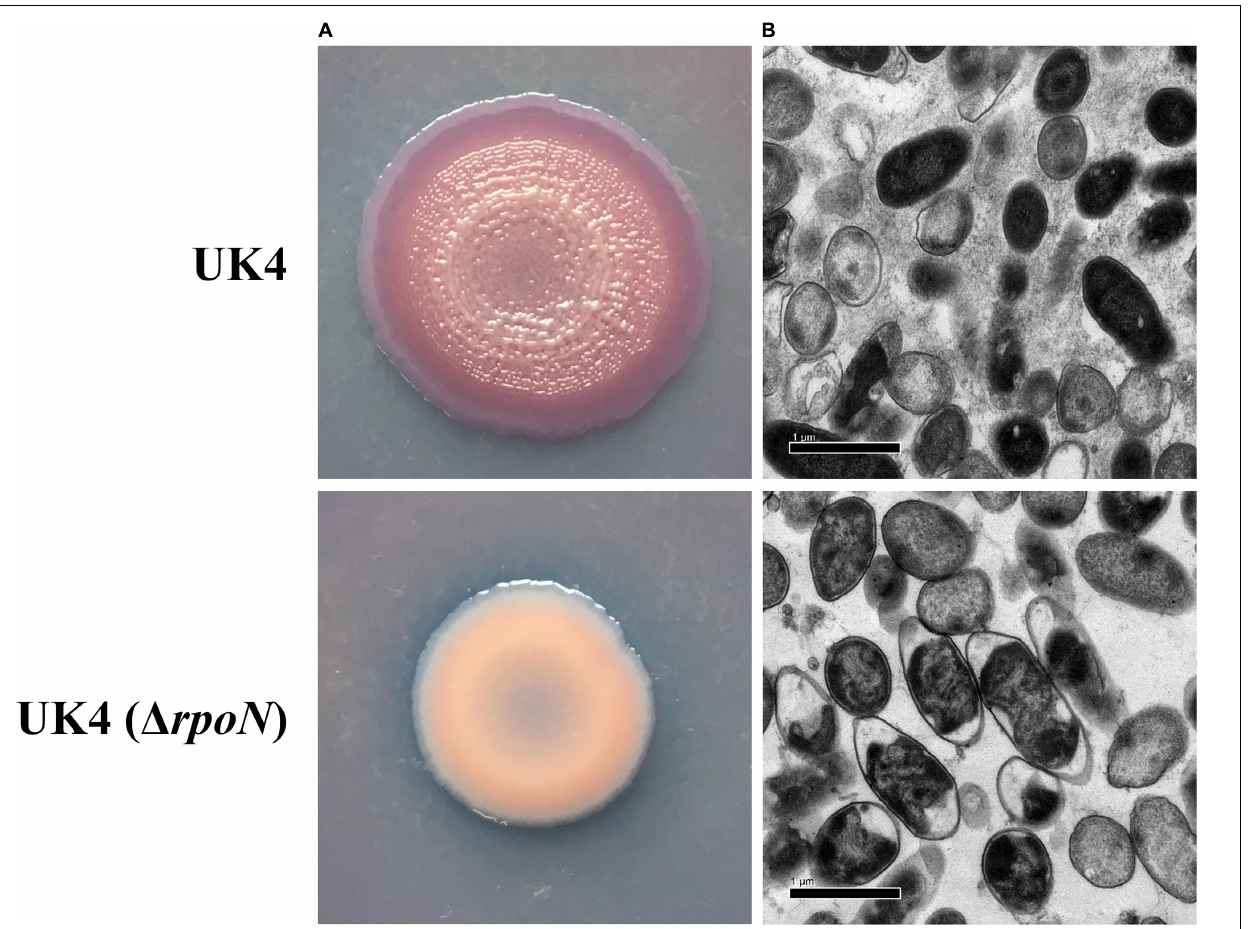
FIGURE 3 | Macrocolony biofilm properties of the P . fluorescens wild-type strain UK4 and the mutant strain (cid:49) rpoN . (A) Macrocolony morphology grown on Congo red and Coomassie brilliant blue plates for 7 days. (B) Transmission electron micrographs of the macrocolony biofilms at × 10,000